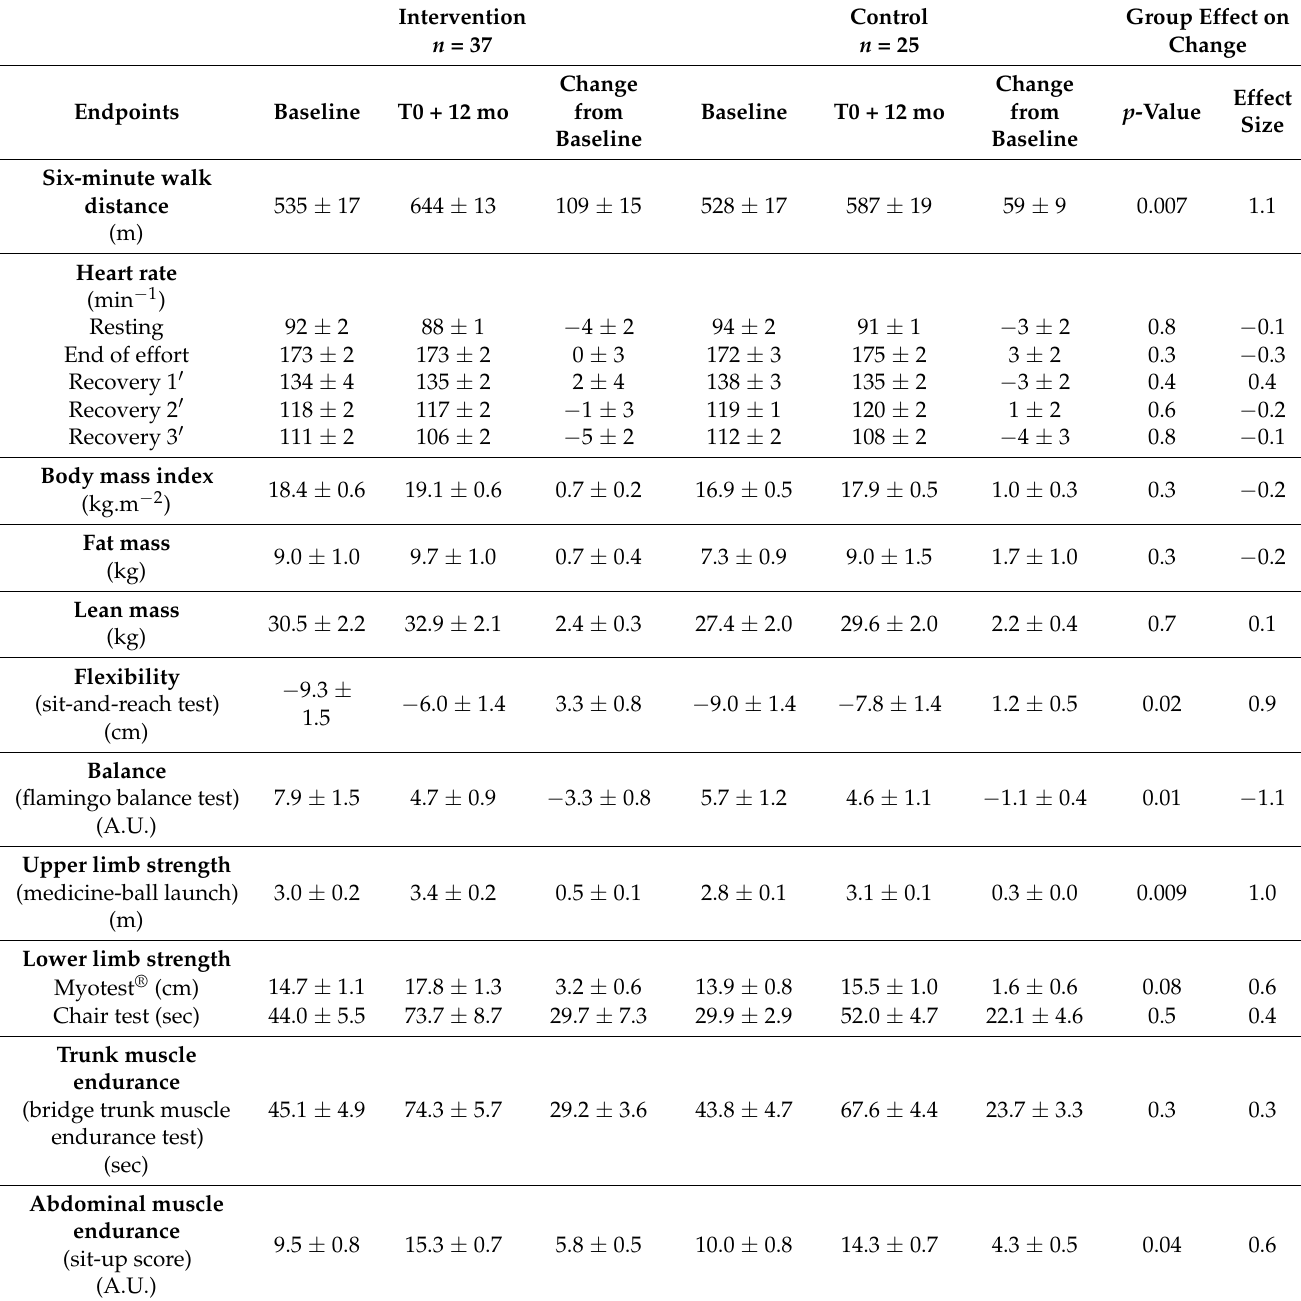
Table 3. Physical endpoints at 12